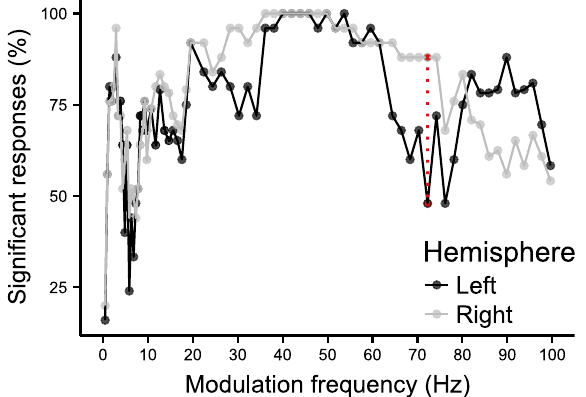
Figure 2. Percentage of significant responses as a function of modulation frequency. The red dashed line indicates the modulation frequency that resulted in a significant difference in the number of significant responses between the left and right hemispheric channel ( p =